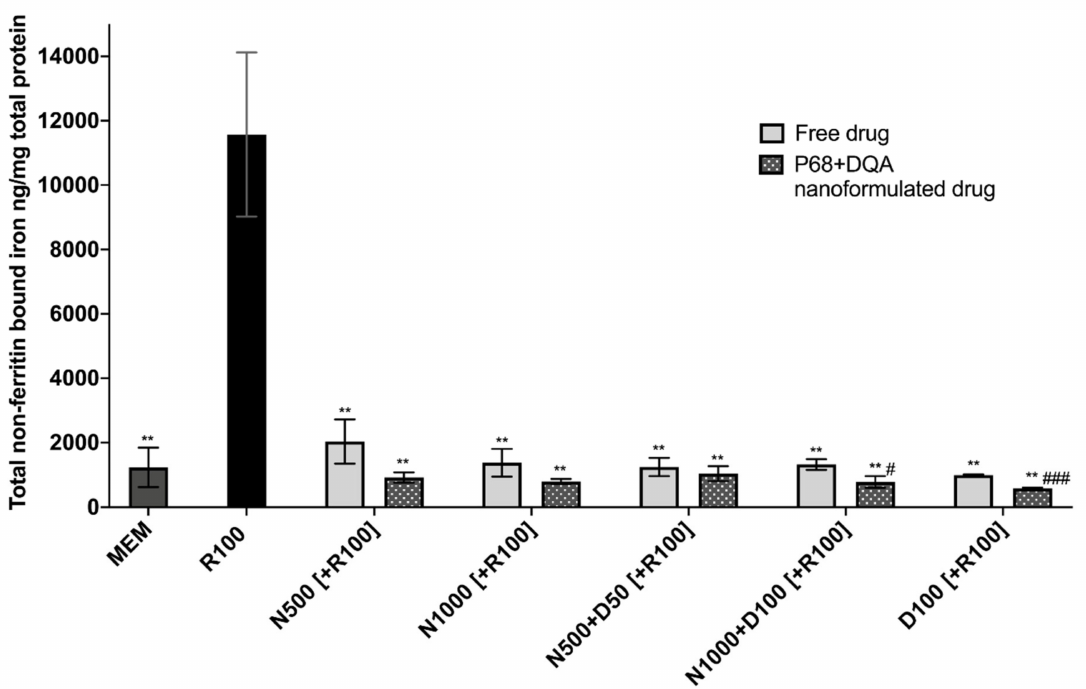
Figure 4. Total non-ferritin-bound iron concentrations resulting from 3 h pre-treatment with free-drug or P68 + DQA nanoformulated preparations of either 500 and 1000 µ M NAC (N500, N1000), combined NAC with 50 or 100 µ M DFO (N500 + D50, N1000 + D100) or 100 µ M DFO alone (D100) followed by 24